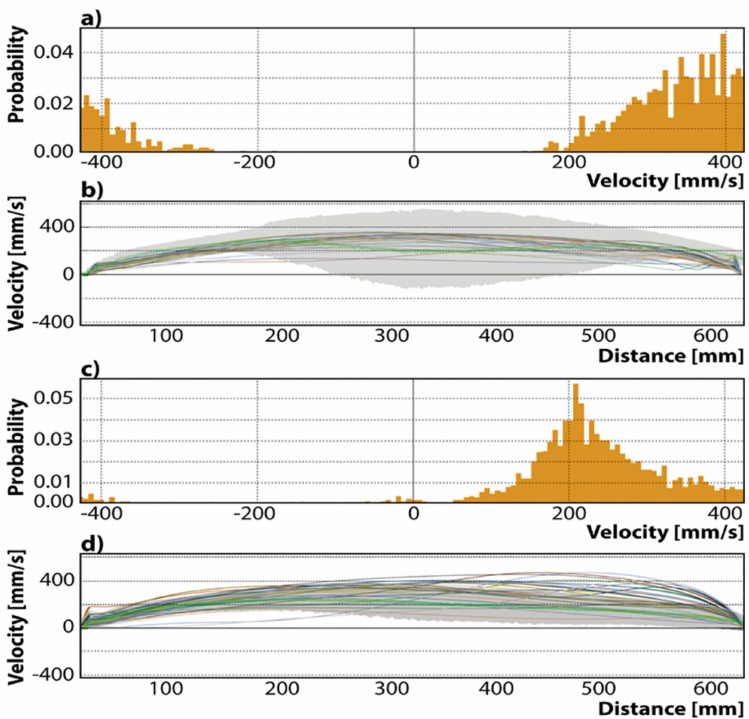
Figure 13. Turbulence features using nozzles without clogging. ( a ) PDF of velocity using nozzle A. ( b ) Velocities calculated by the mathematical model and measured velocity profile using nozzle A. ( c ) PDF of velocity using nozzle B. ( d ) Velocities calculated by the mathematical model and measured velocity profile using nozzle